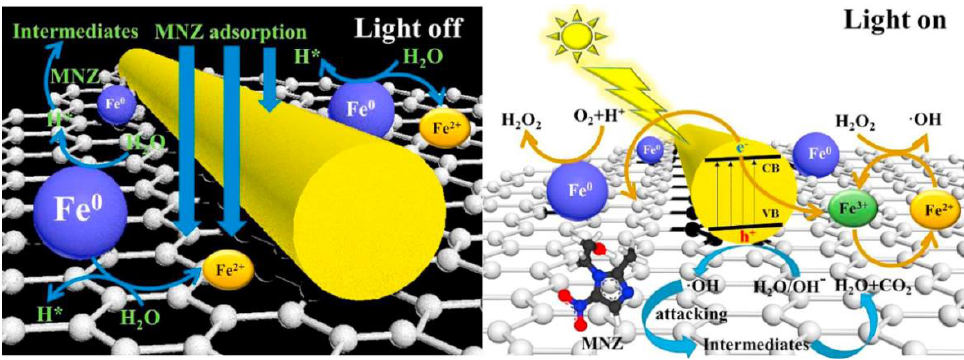
Figure 17. Proposed synergistic photocatalytic mechanism of Fe@GNW nanocomposite for metro- nidazole degradation [128].